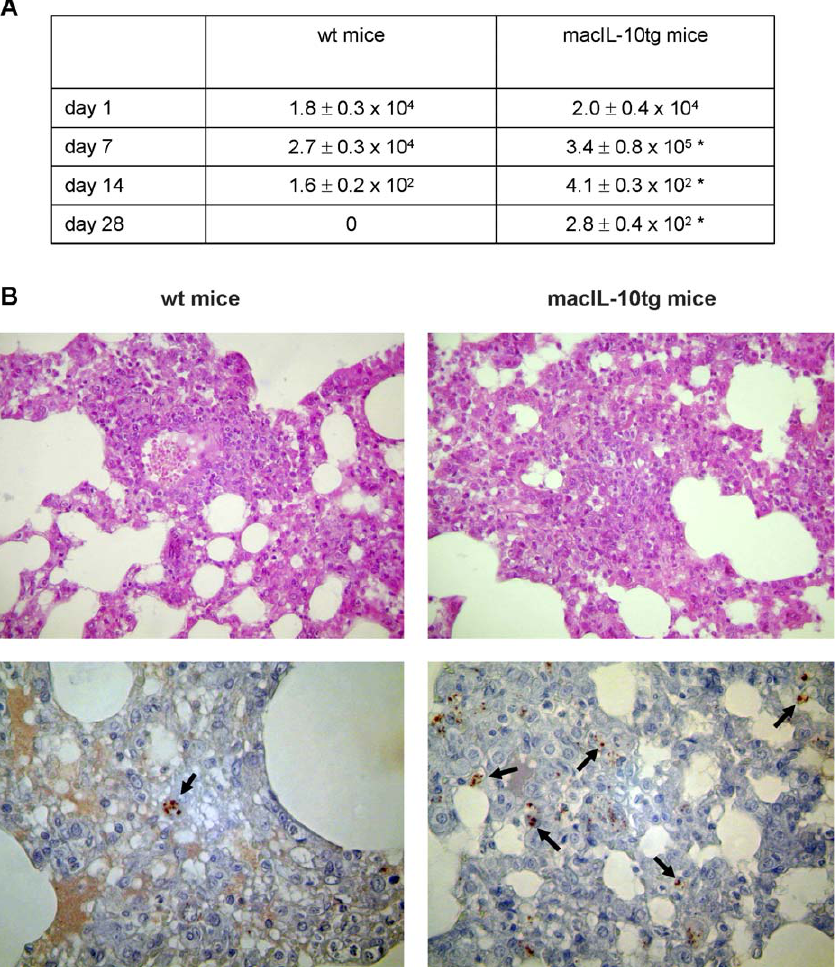
Figure 6. C. burnetii Infection and Pulmonary